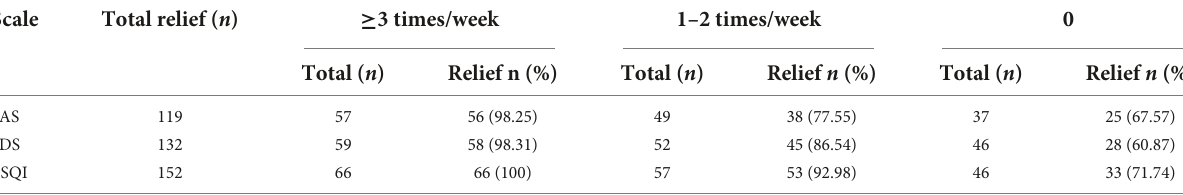
TABLE 5 Comparison of remission rates of anxiety, depression and sleep disorders among subjects at different exercise frequencies.